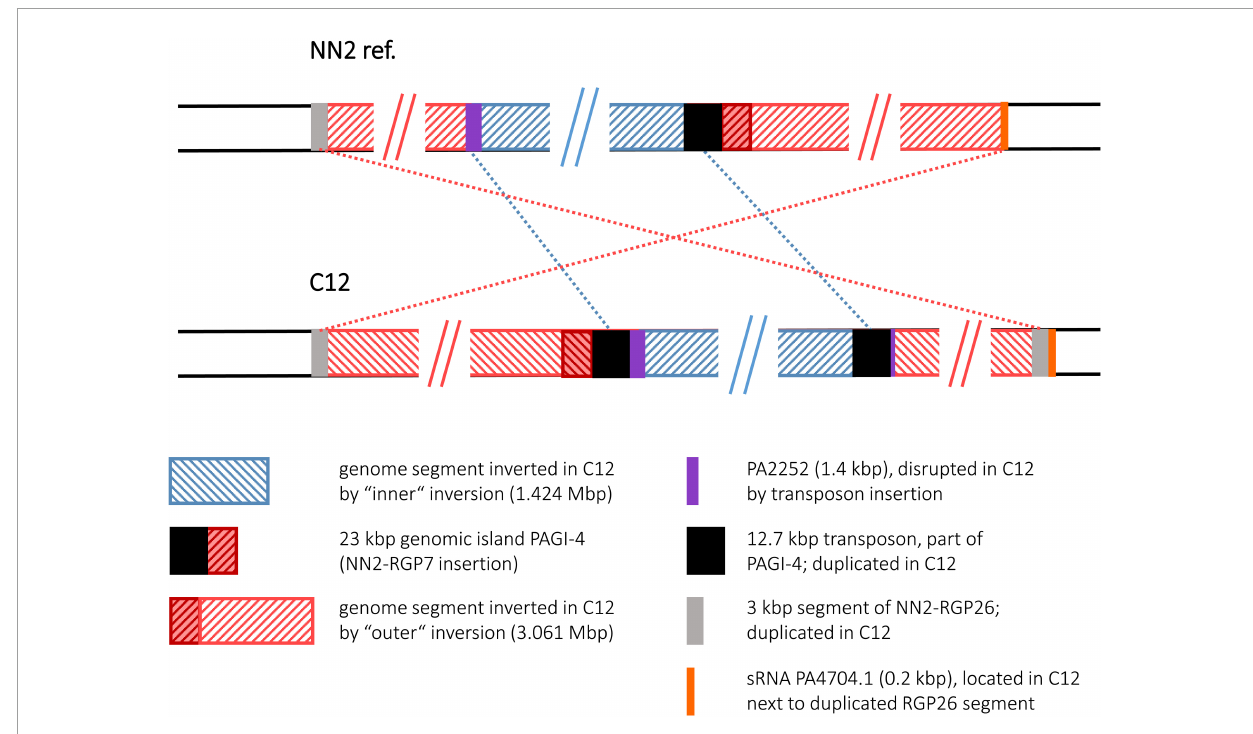
FIGURE5 Genomic inversions in strain C12. This figure illustrates the two large inversions detected in the C12 sequence. As the genome segment of the smaller inversion was encompassed by the segment affected by the larger event, the inversions are shown as “inner” and “outer” events.